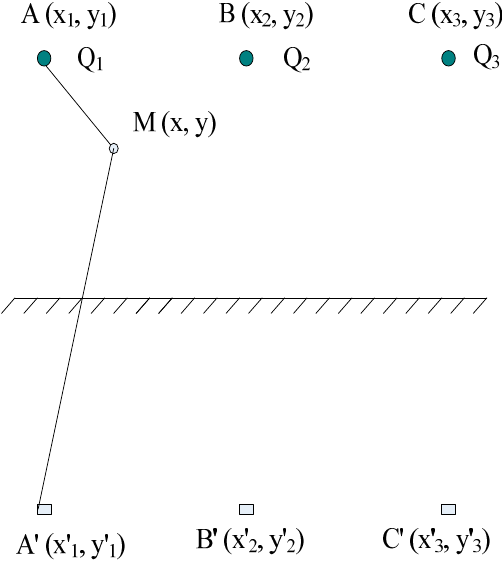
Figure 1. Map of the charge simulation method.